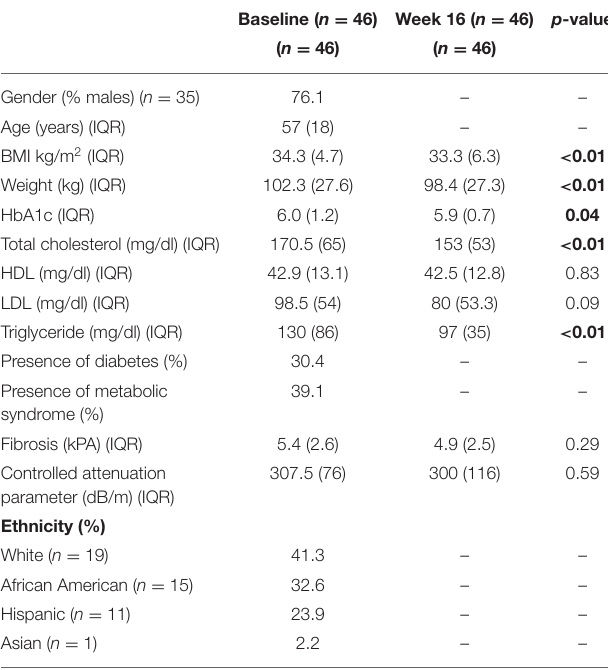
TABLE 1 | Patient characteristics, laboratory values, and ultrasound elastography measurements at baseline and at the end of the study (week